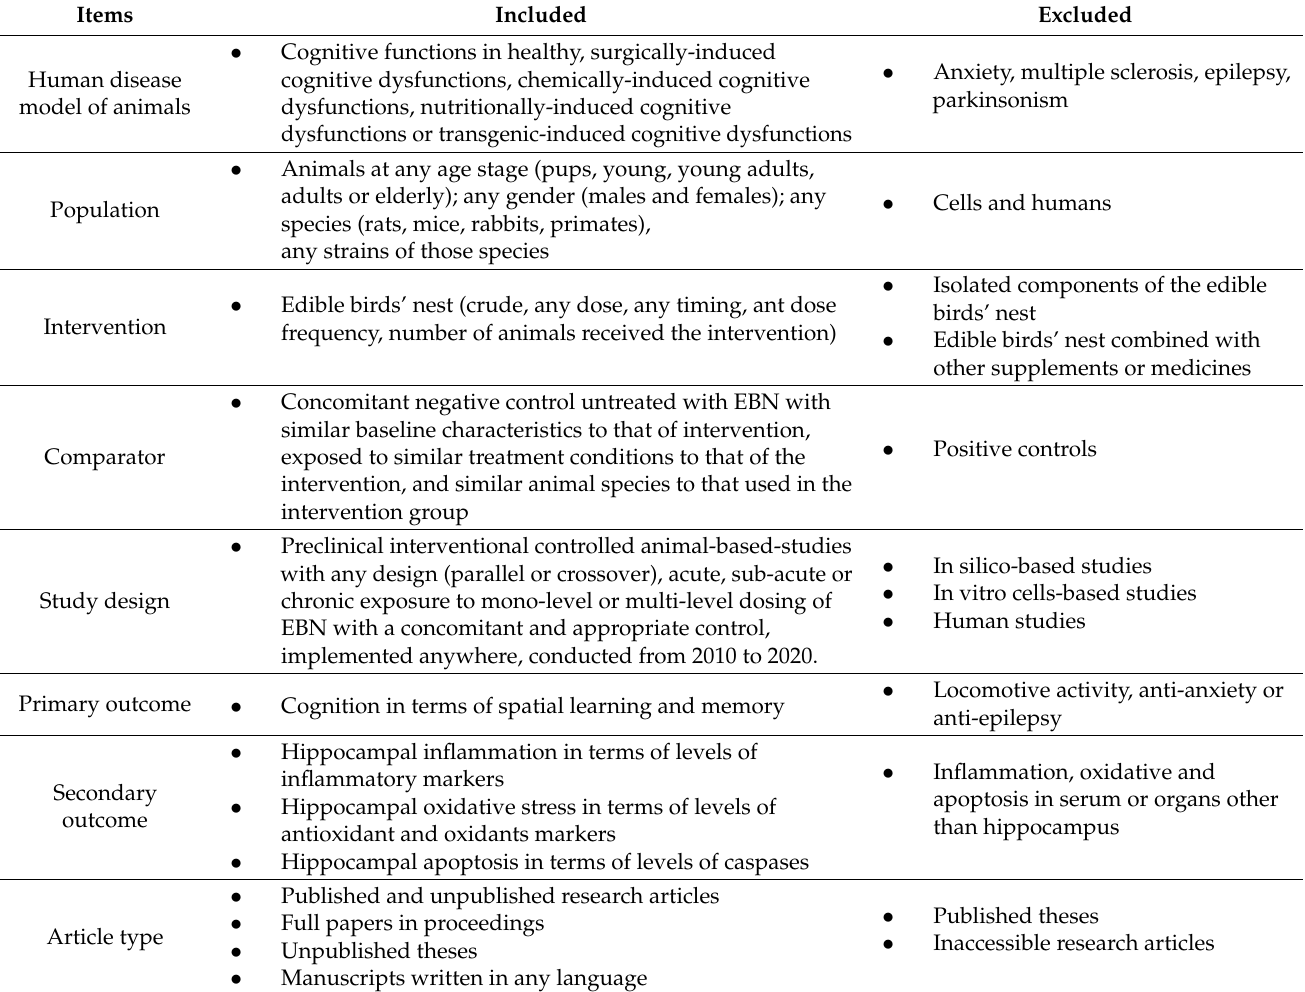
Table 1. Eligibility criteria (inclusion and exclusion